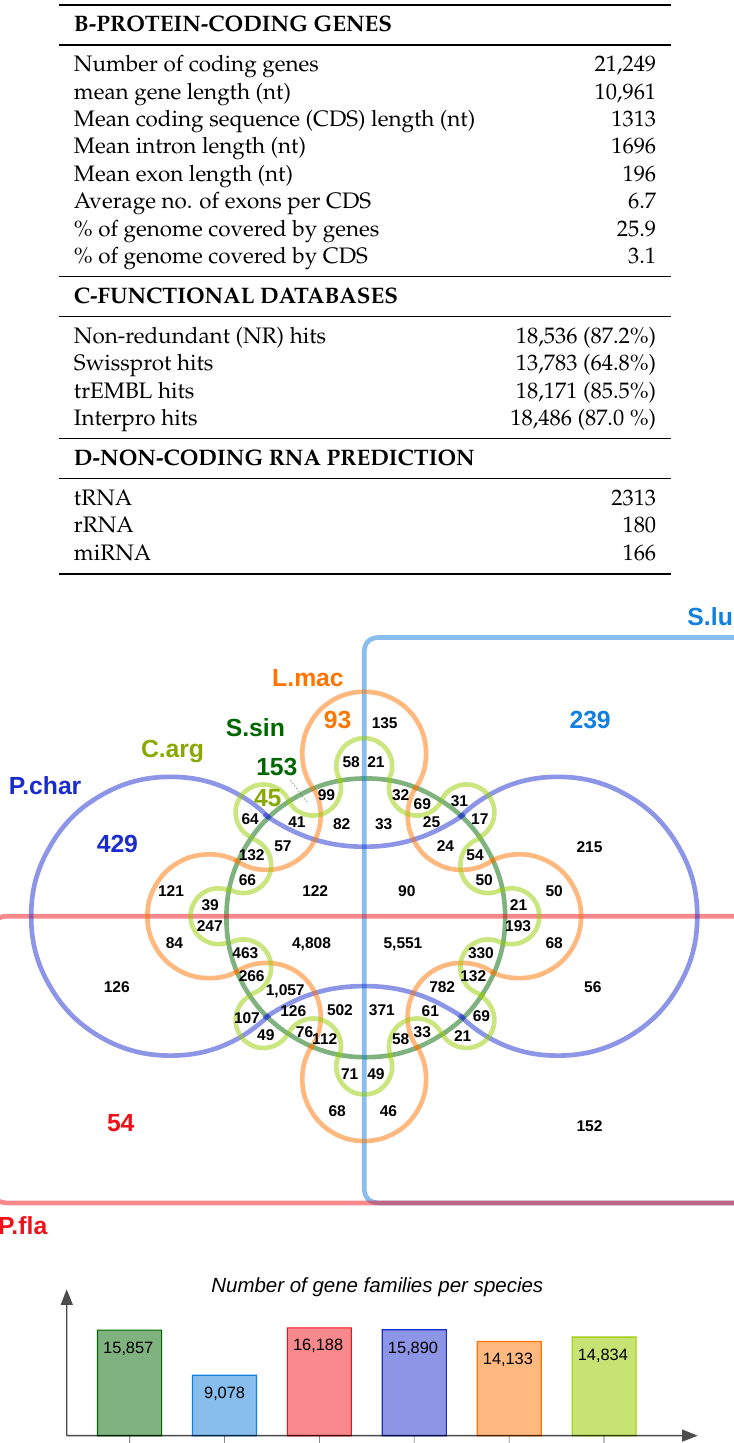
Figure 4. Shared gene families and their distribution per species. ( A ): Venn-diagram showing the shared gene families between selected Perciformes species: L.mac ( Lateolabrax maculatus ), S.sin ( Sillago sinica ), C.arg ( Channa argus ), P.fla ( Perca flavescens ), S.luc ( Sander lucioperca ), P.char ( Parachaenichthys charcoti ). Colored numbers indicate the number of species-specific gene families. ( B ): Total number of gene families for each